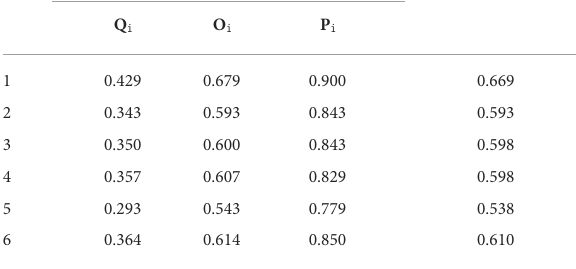
TABLE 6 Defuzzification of S ratings in Fuzzy-FMEA.